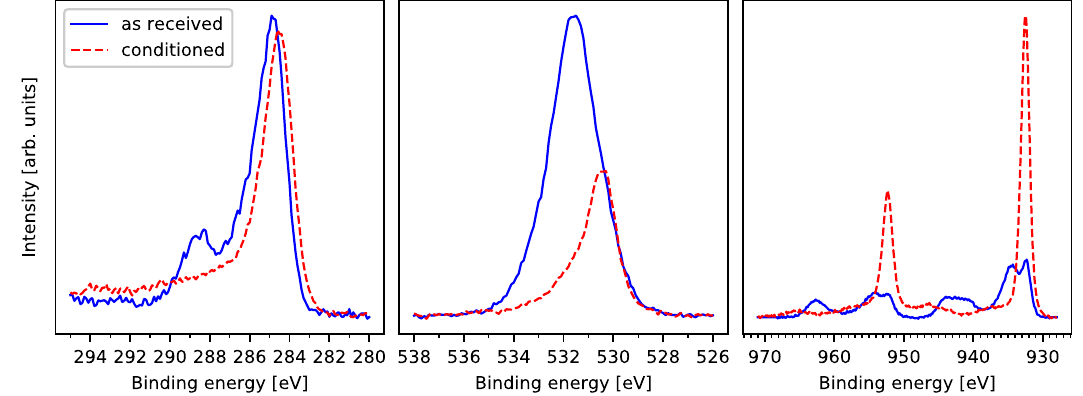
FIG. 2. C 1s (left), O 1s (center) and Cu 2p (right) lines of as received sample, before and after a full conditioning